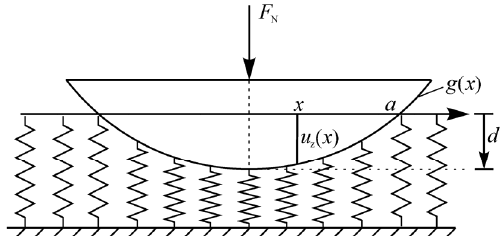
Fig. 6 Schematic presentation of the contact of a